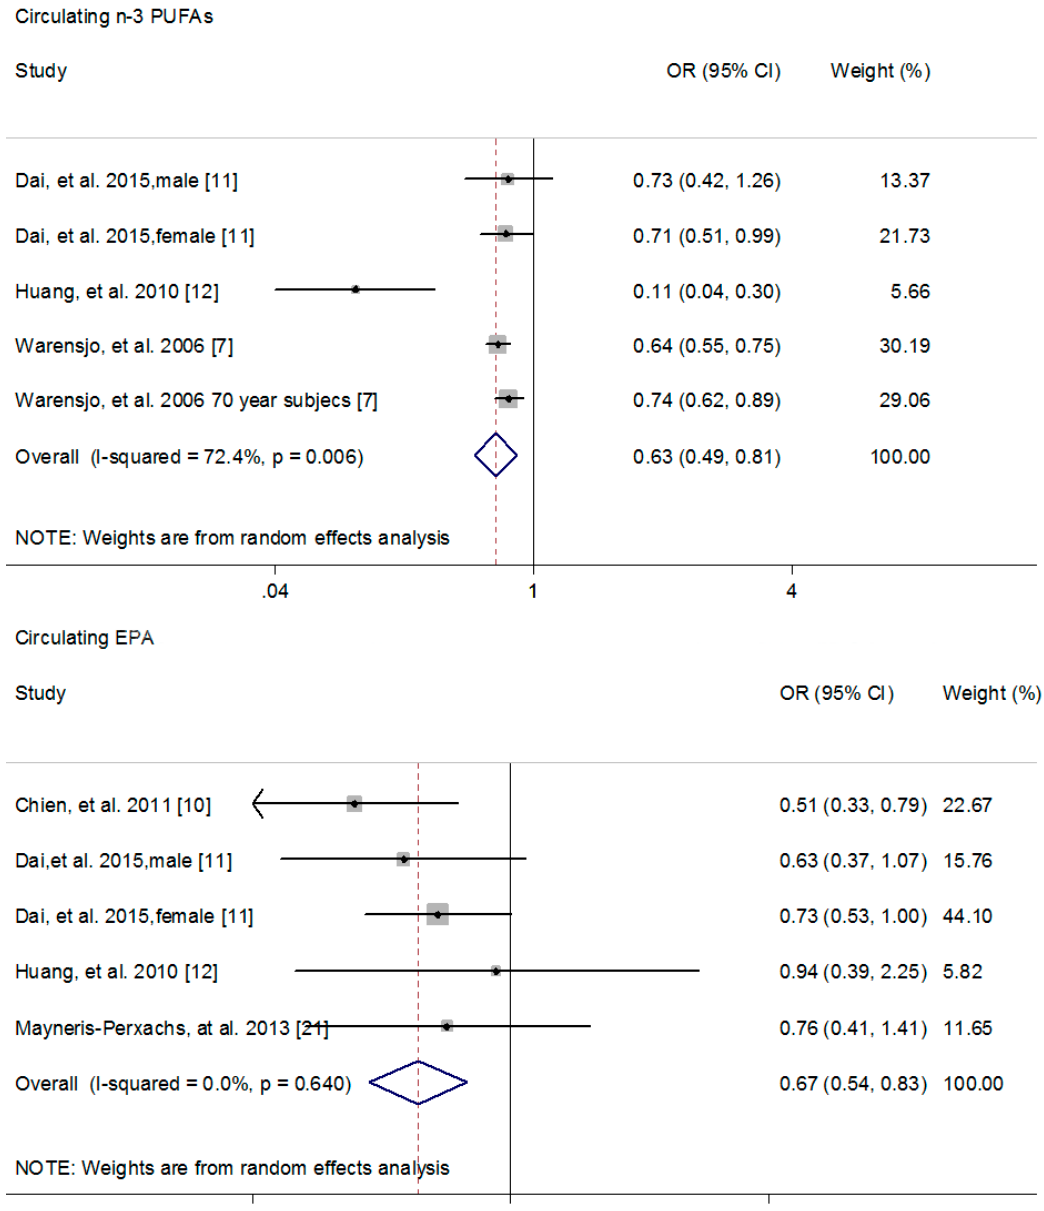
Figure 2. Forest plot to quantify the association of circulating n -3 PUFAs or EPA with metabolic syndrome risk. The pooled ORs were calculated by using a random-effects model for the highest versus lowest category. The diamonds denote summary risk estimate, and horizontal lines represent 95%